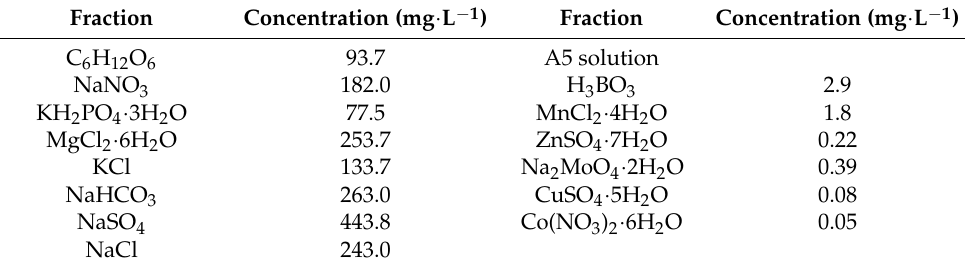
Table 1. The formulation of simulated W ROC